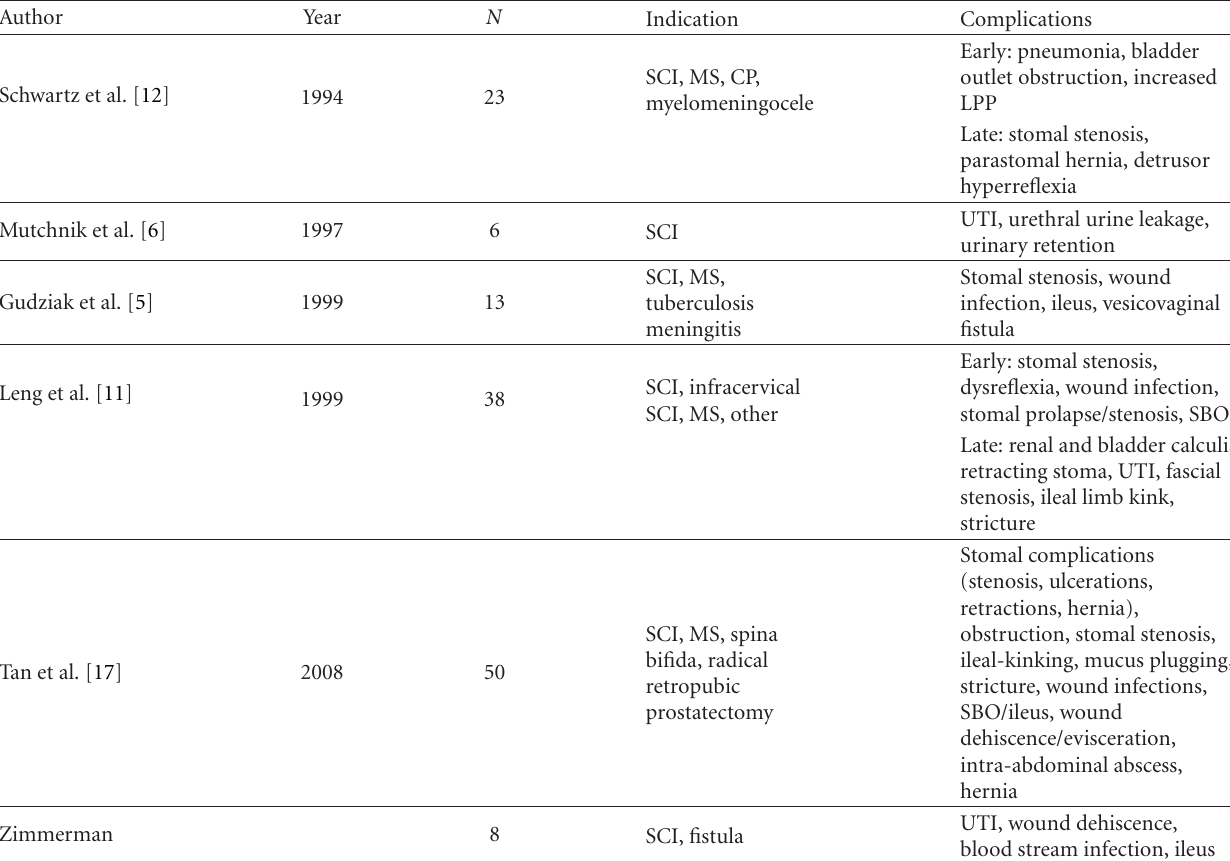
Table 1: Comparison of